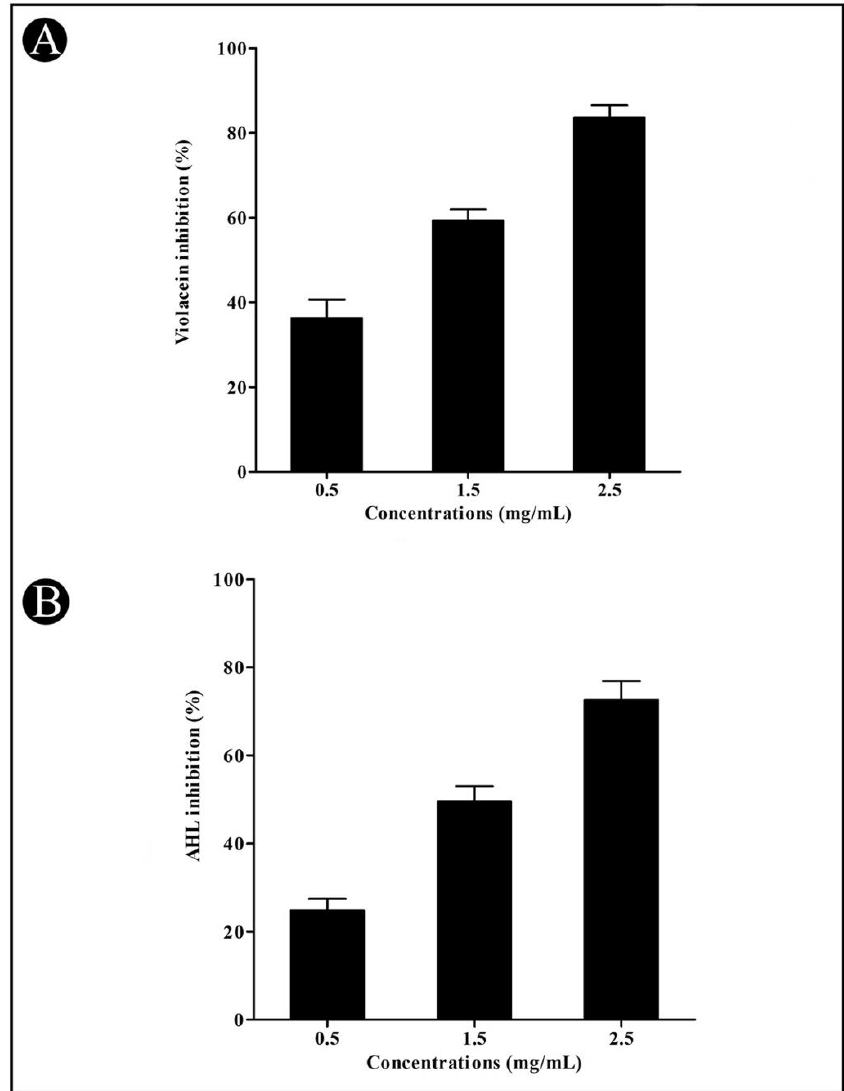
Figure 1. Inhibition of violacein and AHLs by the crude L. plantarum biosurfactant in C. violaceum at sub-MIC concentrations (0.5, 1.5, and 2.5 mg/mL). Violacein ( A ) and AHL ( B ) were detected by a UV–VIS spectrophotometer and presented as percentage inhibition (with respect to untreated control). Values are represented as mean ± SD of three independent experiments.